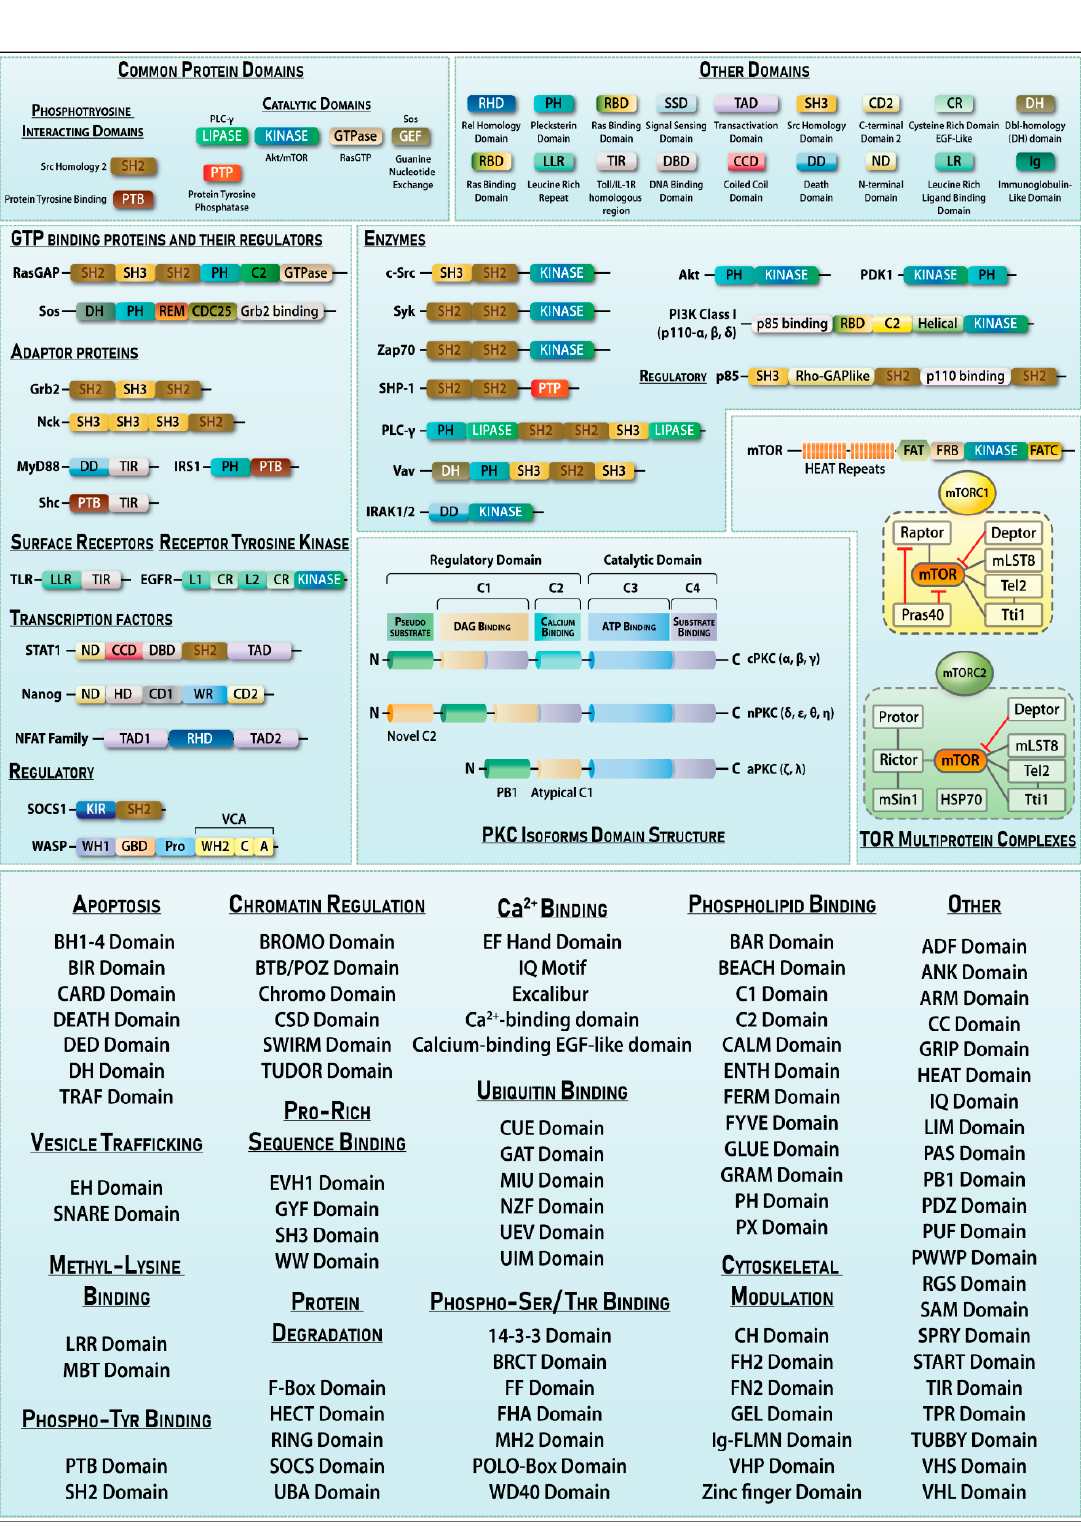
Figure 3. Represents the different protein domains and their categorization based on binding with other molecules and their biological functions. (Note—Sources: http://www.ebi.ac.uk/interpro/; other molecules and their biological functions. (Note—Sources: http: // www.ebi.ac.uk / interpro / ; http://www.cellsignal.com). http: //